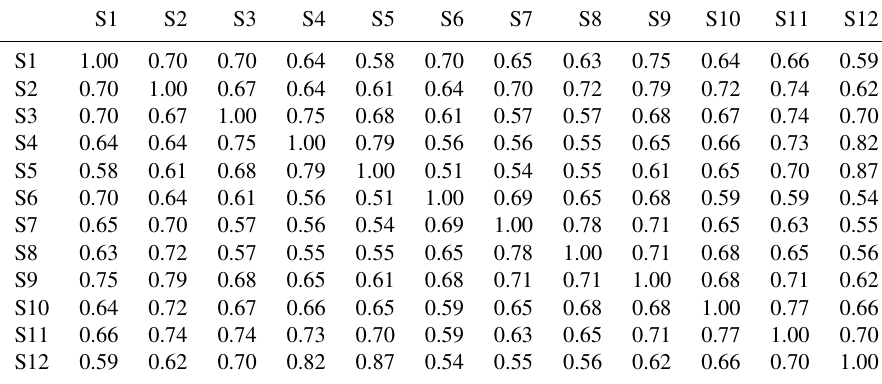
Table 3. Cross-correlation of observed data for 12 stations from the Yeongnam province, South Korea.